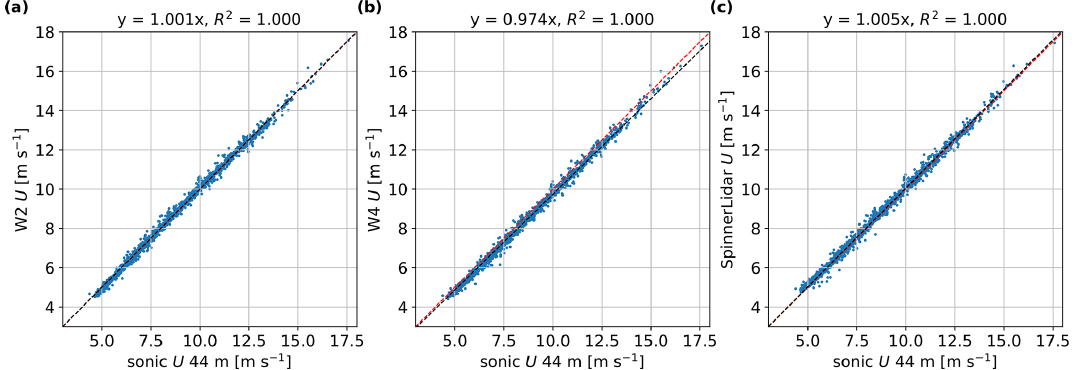
Figure 10. Comparison between the reconstructed along-wind mean velocity from the sonic anemometer at 44m and (a) W2, (b) W4 and (c) SpinnerLidar. All estimates are corrected for the induction. Features regarding the red and black dashed lines as in Fig. 9.